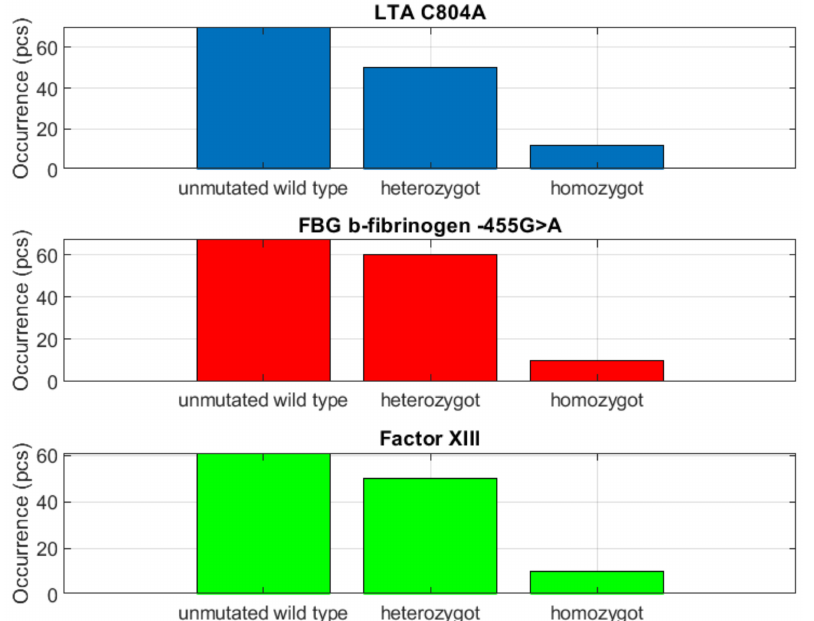
Figure 6. Heterozygous distribution and nonmutant alleles in a 1:1 ratio. The parameter of endothelial receptor thromboembolism, i.e., EPCR A4600G , demon- strated unequivocally negative detection of the mutation. A 50% risk of mutation incidence was inferred based on the results of the 20 to 50% group. The question remains whether testing for these parameters clinical significance has, given that the 1:1 ratio will be less con- tributing than in the greater than 50% group. Individuals with a 50% incidence of mutations harbored endothelial ischemia and thrombogenesis and thrombolysis, i.e., FGB b-fibrinogen , at a ratio of 1:1 for heterozygosity and nonmutated allele. Other representative parameters of the thrombogenesis and thrombolysis, i.e., PAI-1 4G/5G and endothelial receptor thromboembolism, i.e., EPCR G4678C , were dominant on het- erozygote detection (Figure 7).